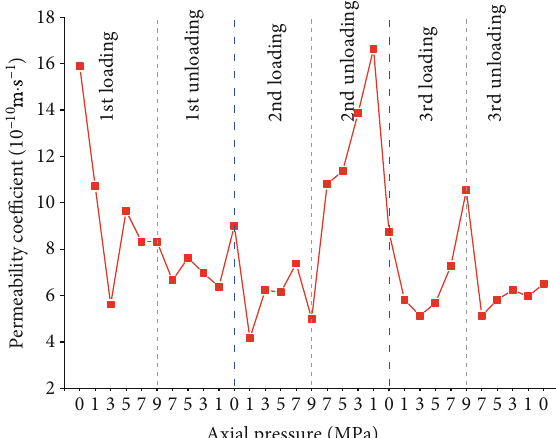
Figure 15: Variation of permeability coe ffi cient under the full-path of loading-unloading the axial stress for fractured